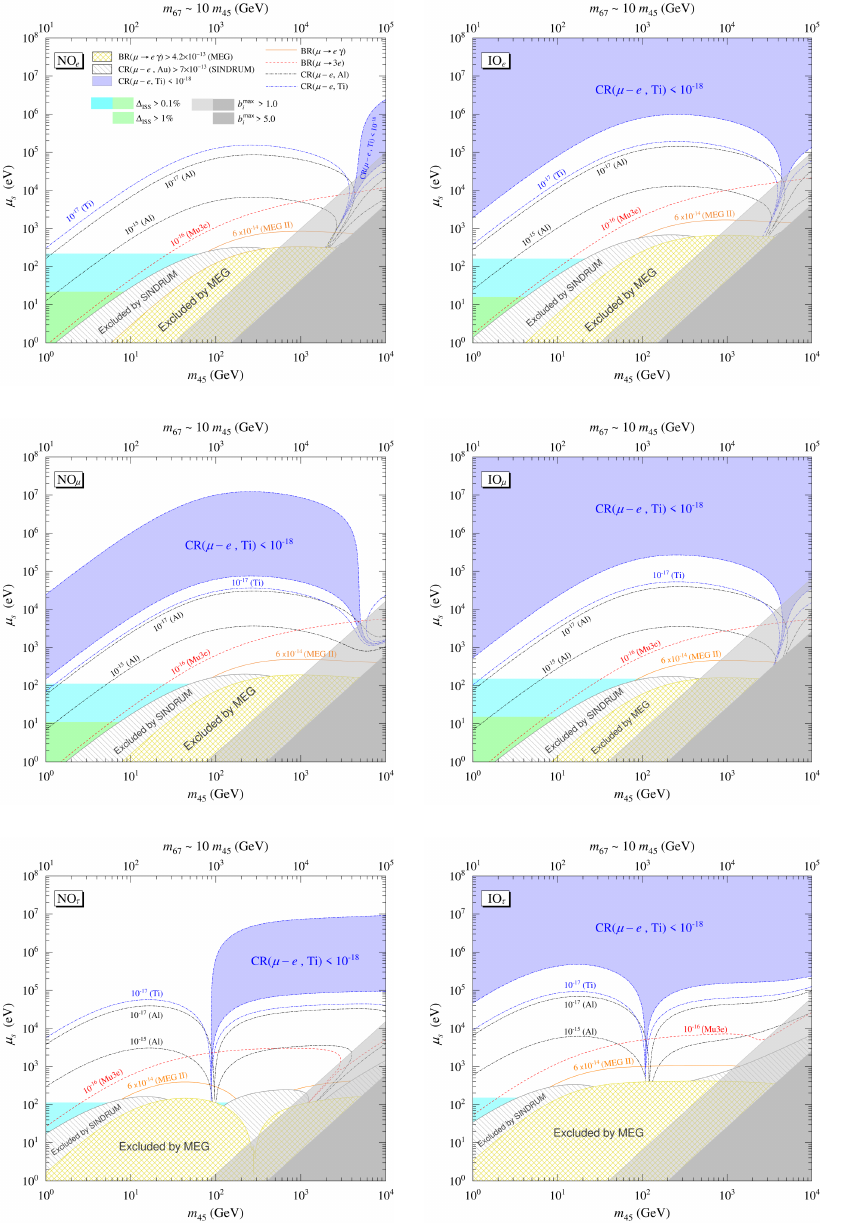
Figure 5 . Constraints on the ( m 45 , µ s ) parameter space imposed by the MEG bound on BR( µ → eγ ) (yellow crosshatched region) and the SINDRUM II limit on CR( µ − e, Au) (grey hatched region). The contours corresponding to the future sensitivities of the MEG II (solid orange) and Mu3e (red dashed) experiments are also given. The black and blue dash-dotted lines show the contours of CR( µ − e, Al) and CR( µ − e, Ti) , respectively, for values within the sensitivity of future experiments (see table 8). In the blue shaded region CR( µ − e, Ti) < 10 − 18 . Limits on b max and ∆ are ISS i also shown (grey, green and cyan shaded regions). The results are shown for all cases found to be realisable through Abelian symmetries, i.e. for the 5 e,µ,τ cases with NO (left panels) and IO (right 1 panels) neutrino mass